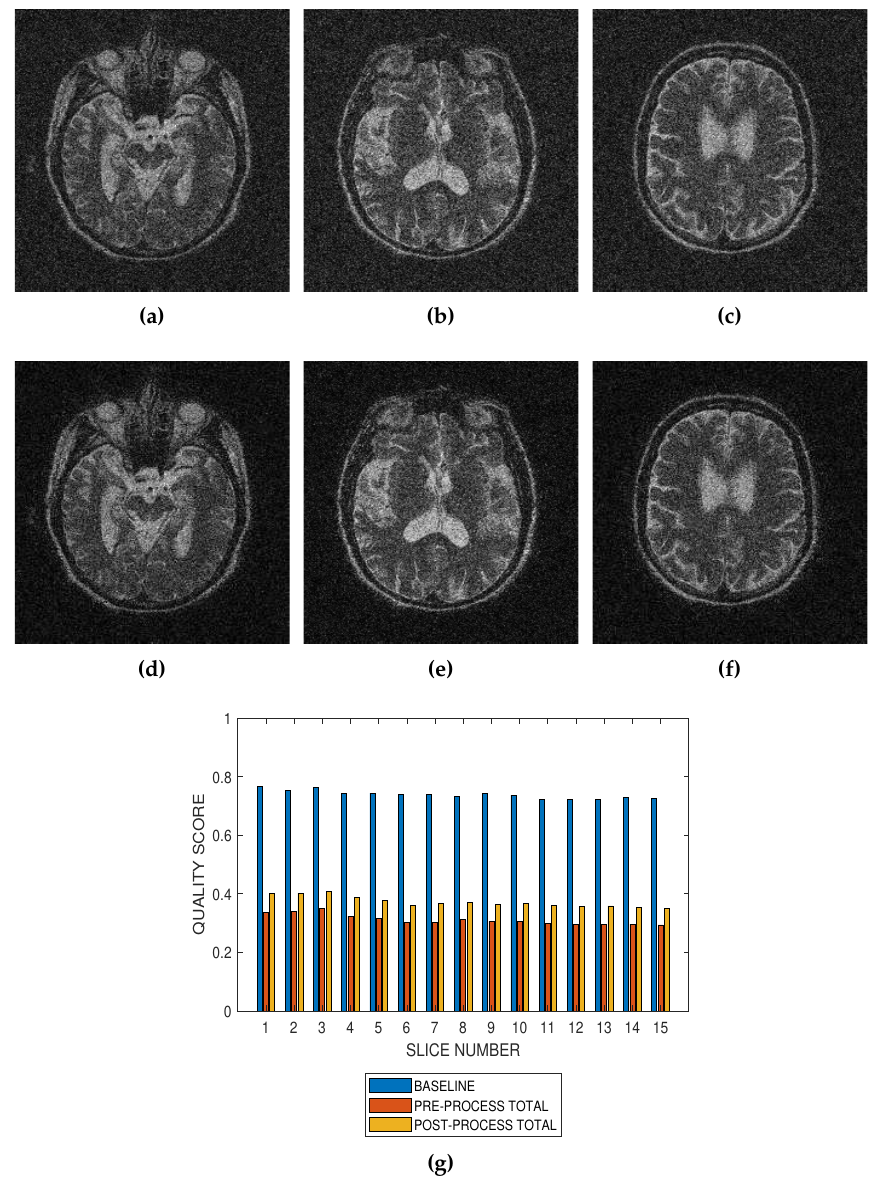
Figure 9. Application of the proposed method to the assessment of an image enhancement algorithm. ( a – c ) are slices numbers 20, 27 and 34, respectively in a T2 MRI volume degraded with 12 percent Rician noise. ( d – f ) are the slices displayed in ( a – c ) but their quality have been enhanced using a bilateral filter. ( g ) The baseline quality score of the original image, the predicted total quality indices of 12 successive T2 MRI slices in a volume data before and after enhancement with a bilateral filter.